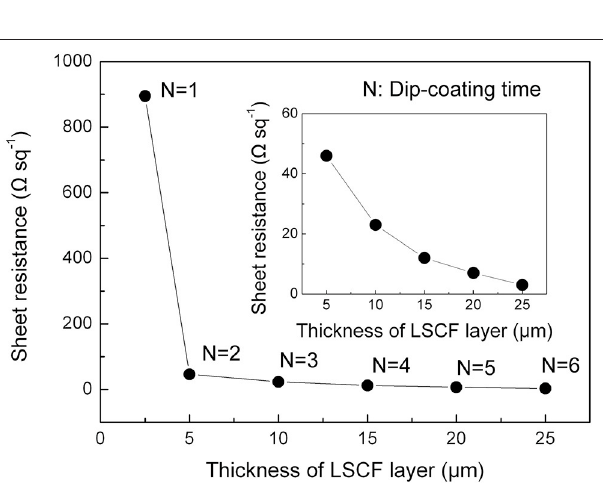
FIGURE 3 | Sheet resistance of the LSCF cathode layer vs.